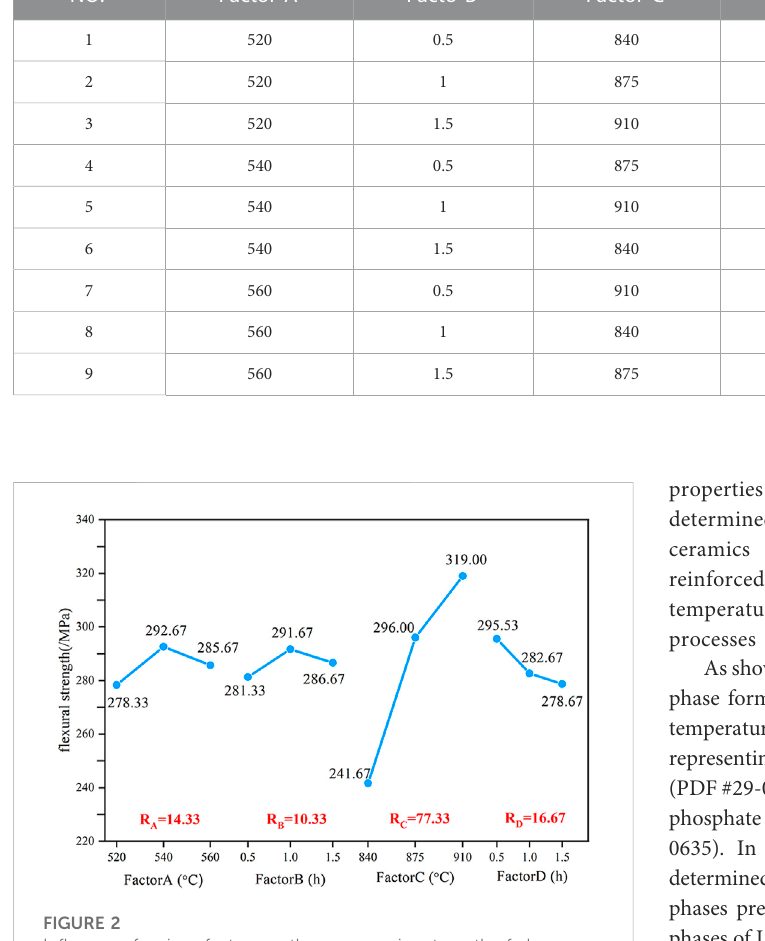
TABLE 3 Orthogonal Experiment Design and Corresponding mechanical properties Results. NO.